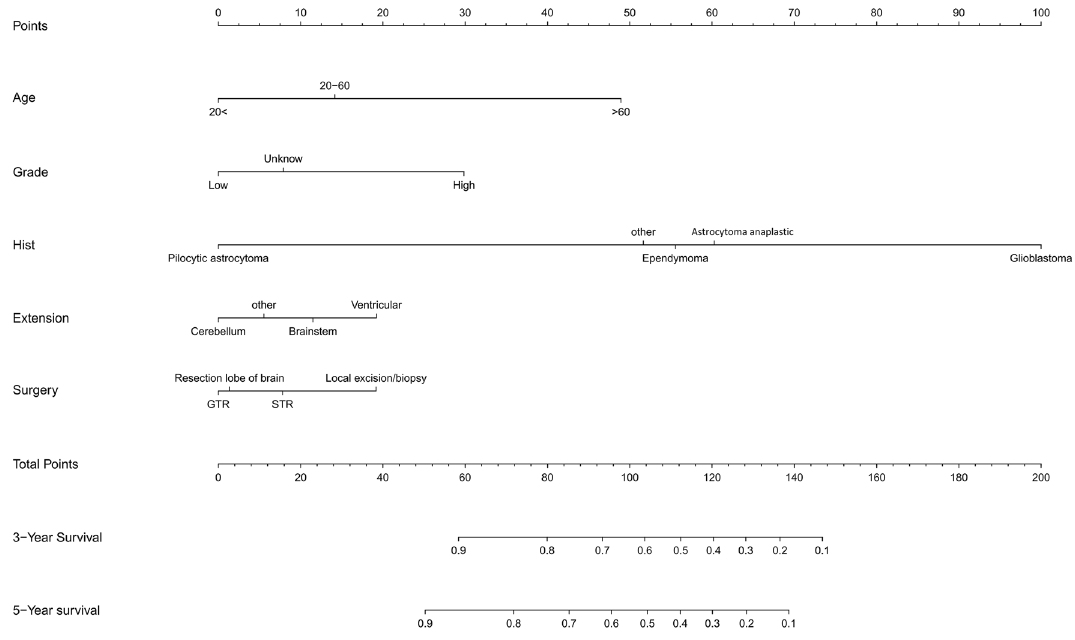
Figure 3. Nomogram for overall survival rate based on training